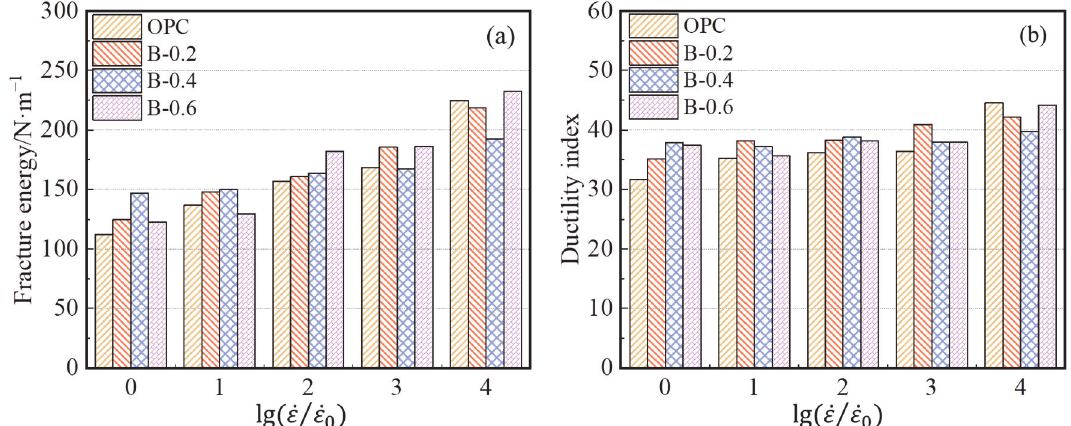
Figure 12. ( a ) The fracture energy and ( b ) ductility index of BFAPC with different fiber contents. Compared with OPC, it can be seen that the fracture energy of 0.6% BFAPC had little improvement or was even decreased at a strain rate of 10 − 6 s − 1 or 10 − 5 s − 1 , while its fracture energy at a strain rate of 10 − 4 s − 1 or higher strain rate was the highest. Therefore, in order to obtain a more intuitive difference of strain rate effect in group B-0.6, the change rule of crack length and crack tip opening displacement (CTOD) throughout the BFAPC fracture process was examined by DIC. The displacement and strain contour diagrams at the peak load at 10 − 6 s − 1 strain rate are shown in Figure 13a,d, respectively, while the lateral displacement changes at y = 40 mm and y = 66.85 mm are shown in Figure 13b,c, respectively. The crack opening displacement (COD) value is equal to the difference in displacement between the start and end points of the jump, and the generation of microcracks leads to the fluctuation of lateral displacement. Referring to the relevant literature [31,48], the location where the COD is about 5 µ m is defined as the crack tip. Finally, the CTOD and crack length can be determined. Based on comprehensive analysis of strain contours at 10 − 6 s − 1 and 10 − 4 s − 1 strain rate, Figure 14a–e show the strain contour maps at pre-60% P max , pre-80% P max , P max , post-80% P max , and post-20% P max stages at 10 − 6 s − 1 and 10 − 4 s − 1 strain rate, respectively. The larger the tension displacement of COD, the higher the consumed energy and peak load. Additionally, the results of pertinent research by Ma [21] and Zhu [23] have indicated that the fracture length and opening displacement increase with loading rate. BFAPC with 0.6% content had a smaller CTOD value but a longer crack propagation length at a strain rate of 10 − 6 s − 1 . This means that the fracture energy at this strain rate is low and the specimen is susceptible to failure, as the spreading of cracks could not be effectively contained by the fiber. However, the CTOD is greater and necessitates more energy consumption at a strain rate of 10 − 4 s − 1 . During the gradual upward expansion of the crack, the incorporated fibers inhibit crack extension. This explains the result that 0.6% BF content was more suitable at higher strain rates from another perspective.